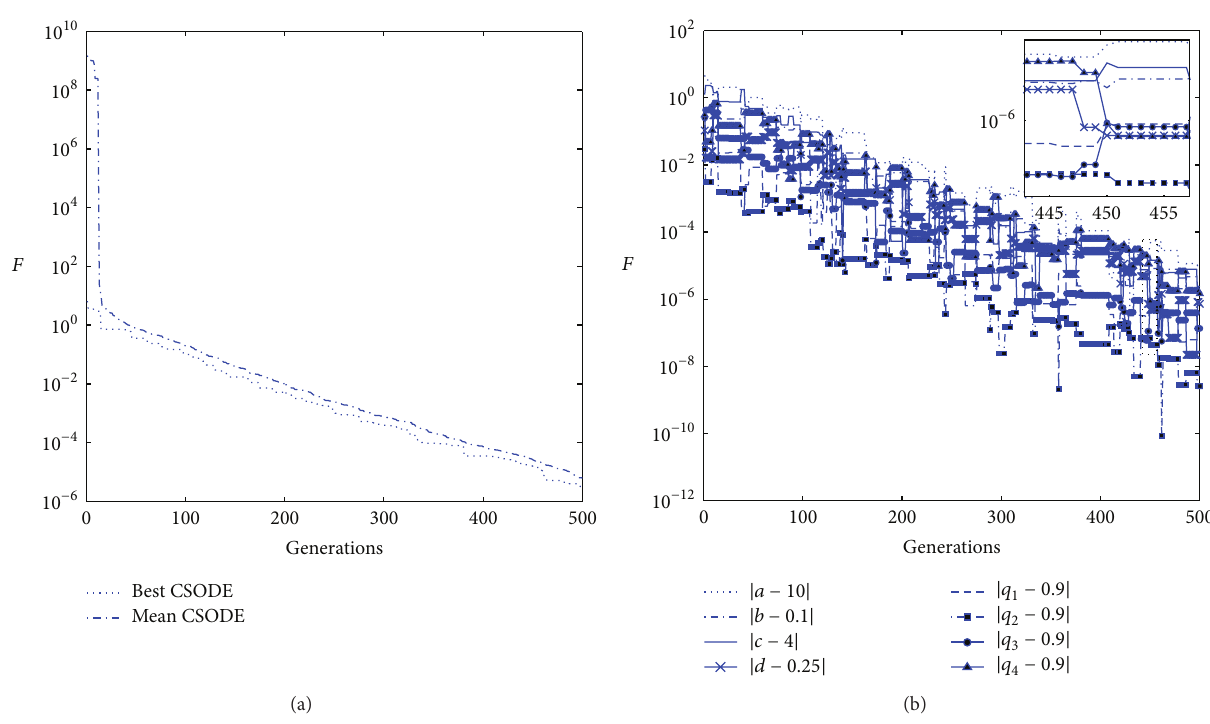
Figure 9: Evolution process for hyper fractional-order Liu